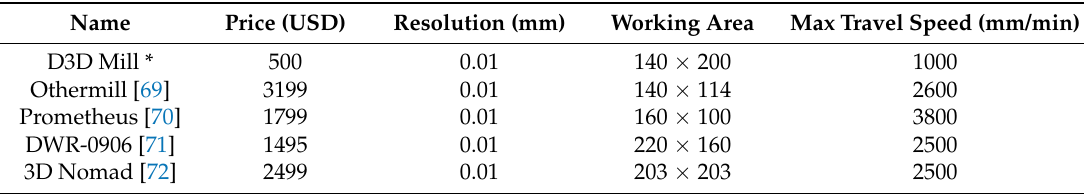
Table 4. A comparison of commercial circuit mills to the D3D